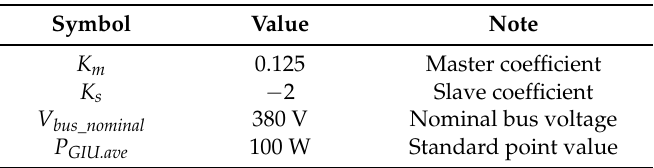
Table 2. Master and slave curve design values of the simulation.